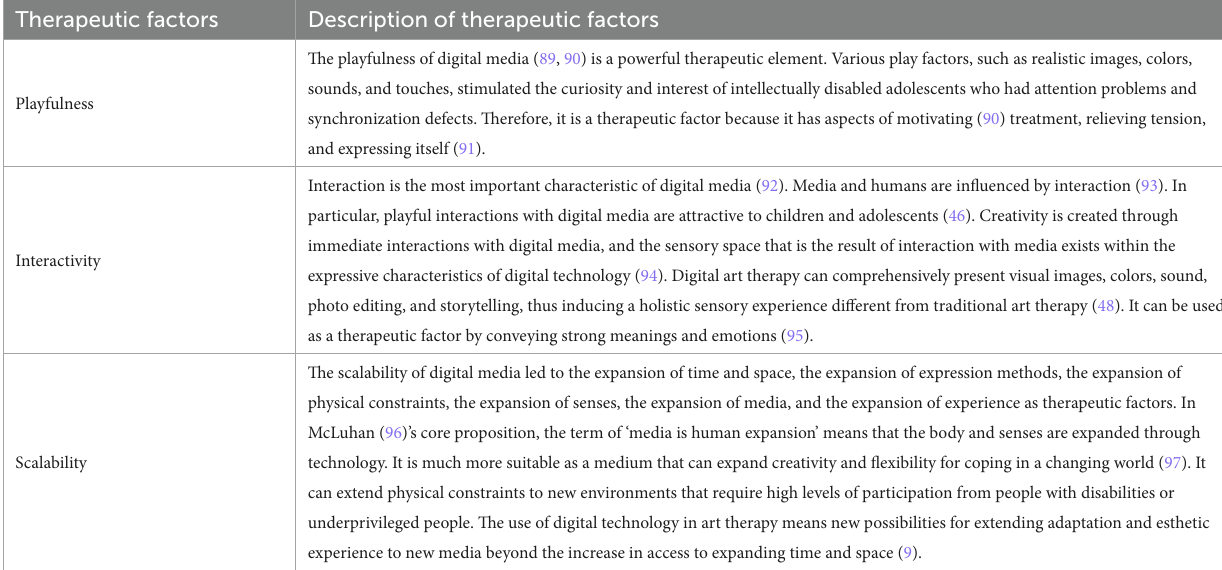
TABLE 6 Therapeutic factors of group art therapy using digital